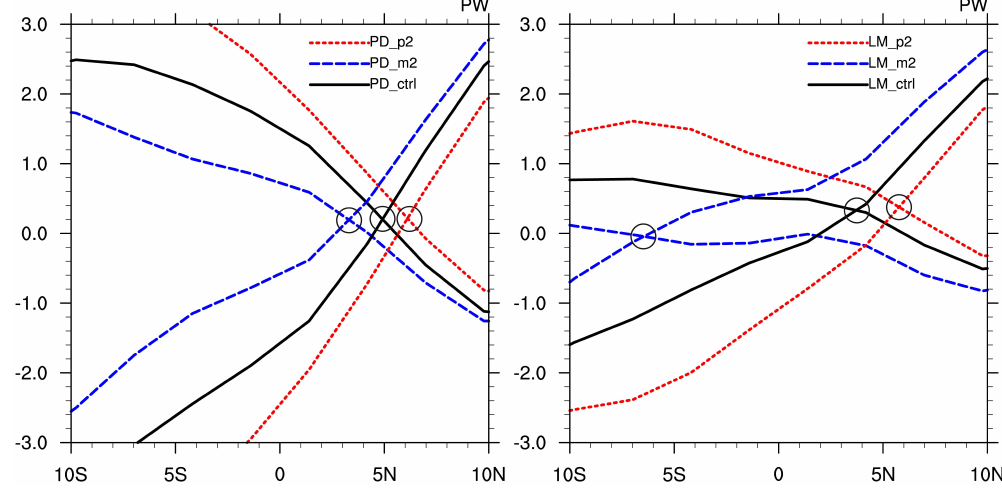
Fig. 9. Locations of annual DSE and latent heat transport crossovers in PD (left panel) and LGM (right panel)